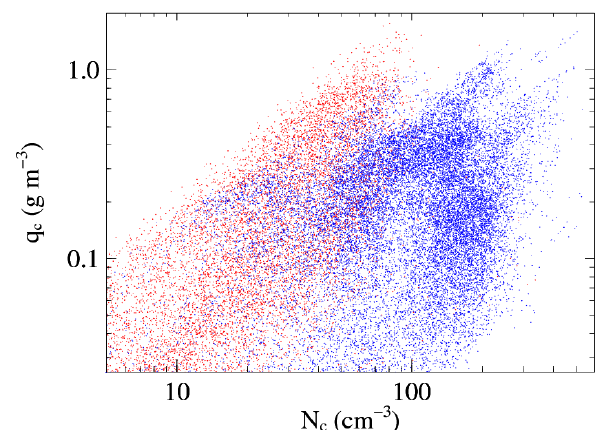
Fig. 1. Scatter-plot of the droplet number concentration, N c , and the LWC, q c , for droplet spectra sampled at 1Hz, during the ACE2 (blue) and RICO (red) field experiments.